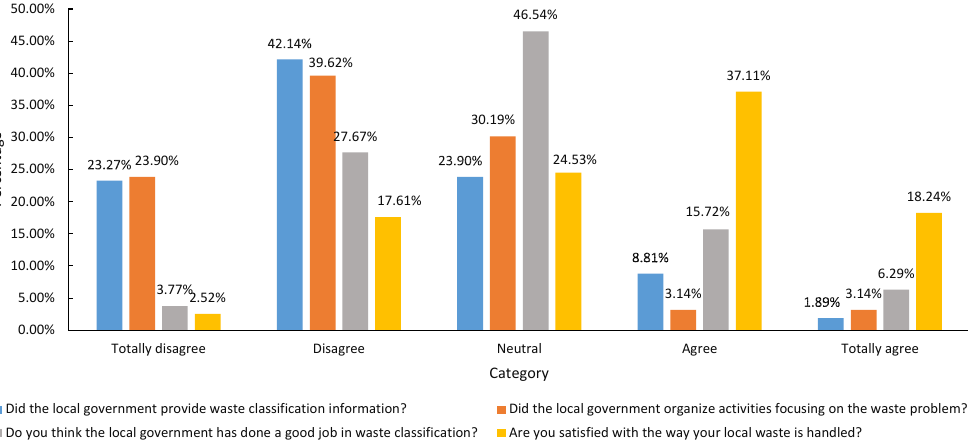
Figure 6. Farmers’ perceptions of the role of local authorities in waste management.